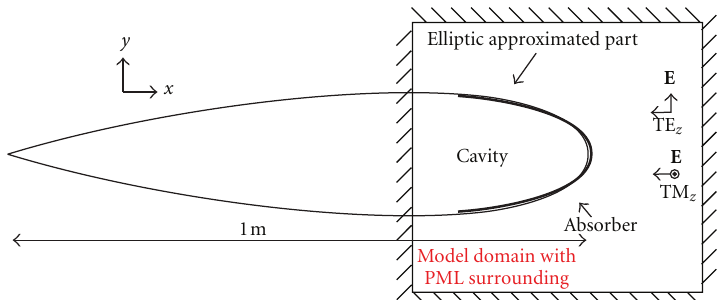
Figure 1: The cross-section of the aircraft wing profile. The simulated model is shown in the box surrounded by PML.